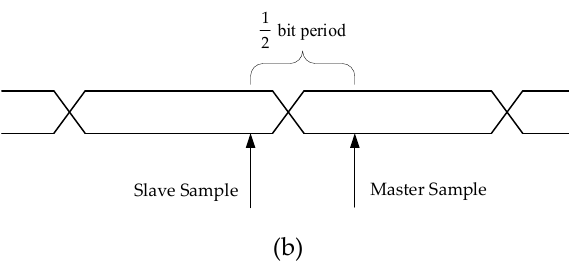
Figure 9. ( a ) Master sampling point is too late in a bit period. ( b ) Master sampling point too early in a bit period.